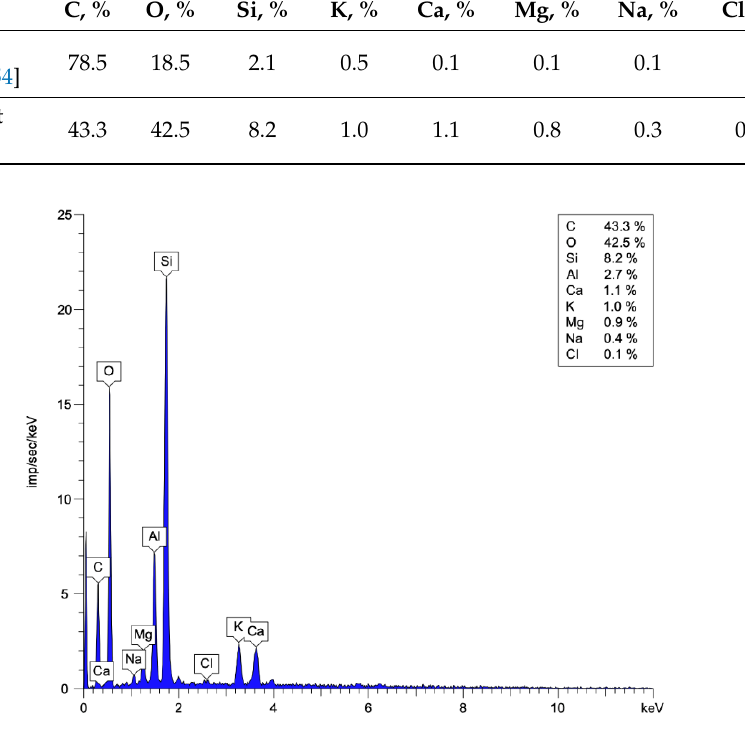
Figure 2. Chemical composition of rice straw biochar without electromagnetic treatment.